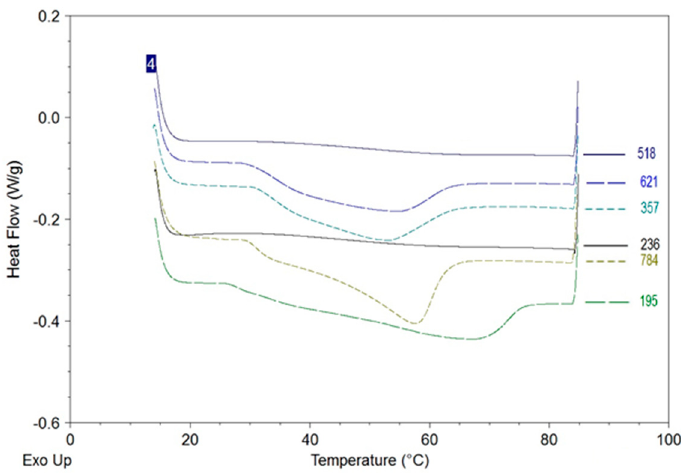
Figure 1. Thermograms of samples obtained by DSC. Citrus honey samples are identified by code 518 (liquid), 621 (creamy), 357 (crystallized). Rape honey samples are identified by code 236 (liquid), 784 (creamy) and 195 (crystallized).